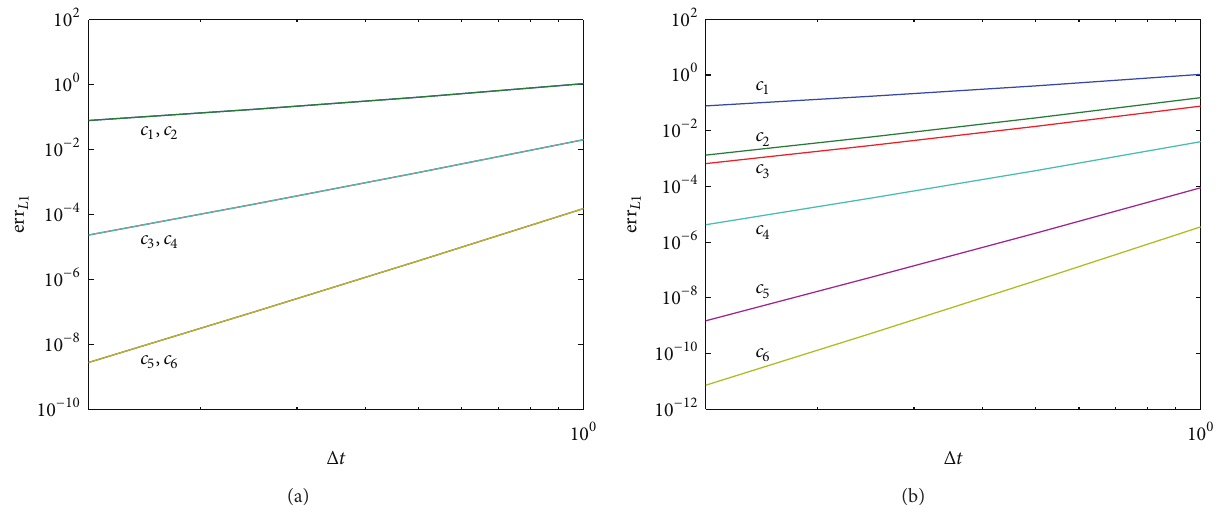
Figure 7: Numerical errors of the one-sided and two-sided splitting schemes: one-sided splitting over 𝐴 (a) and two-sided splitting scheme alternating between 𝐴 and 𝐵 (b) with 1, ...,6 iterative steps.